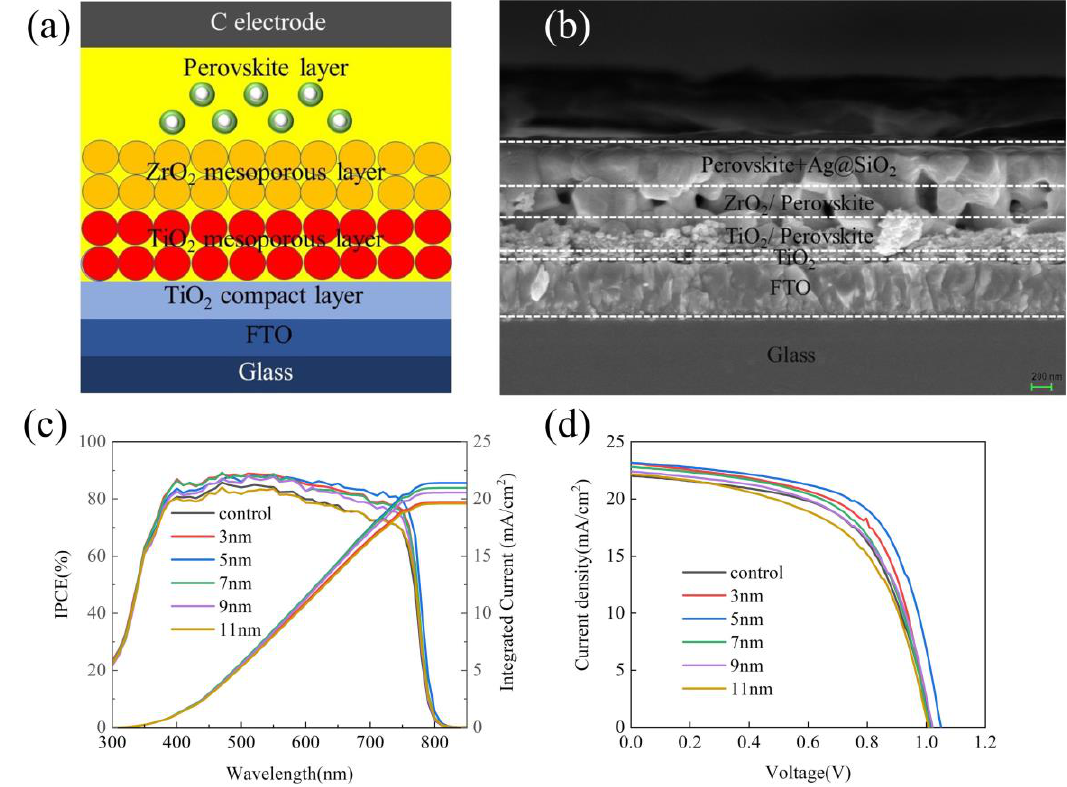
Figure 5. ( a ) Perovskite solar cells (PSC) schematic structure. ( b ) SEM image of a PSC cross section. ( c ) IPCE spectrum of PSCs with Ag@SiO 2 core-shell nanoparticles with different shell thicknesses. ( d ) J-V curve of PSCs with Ag@SiO 2 core-shell nanoparticles with different shell thicknesses. The properties of PSCs with 0.1 wt% (from the reported literature) Ag@SiO 2 core-shell